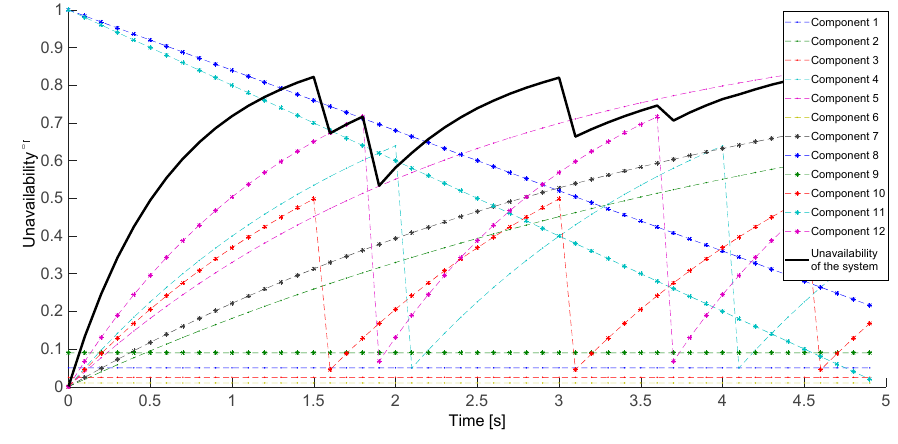
Figure 4. Unreliability of a system.